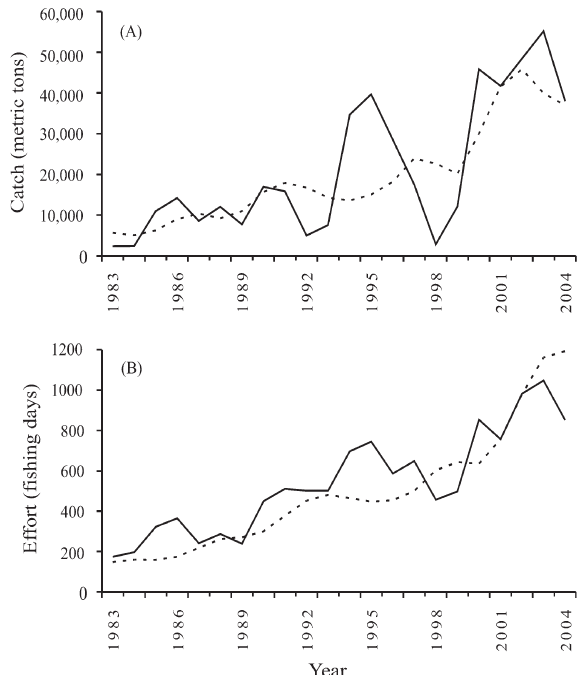
Fig . 4. – Validation of the bioeconomic model by comparing the observed and simulated values for catch and effort for fishing years 1983 to 2004. the two variables showed no significant differences, ( P> 0.39) and ( P> 0.24), respectively. (a) Catch; (B) effort; (—) observed values; and (- -) simulated